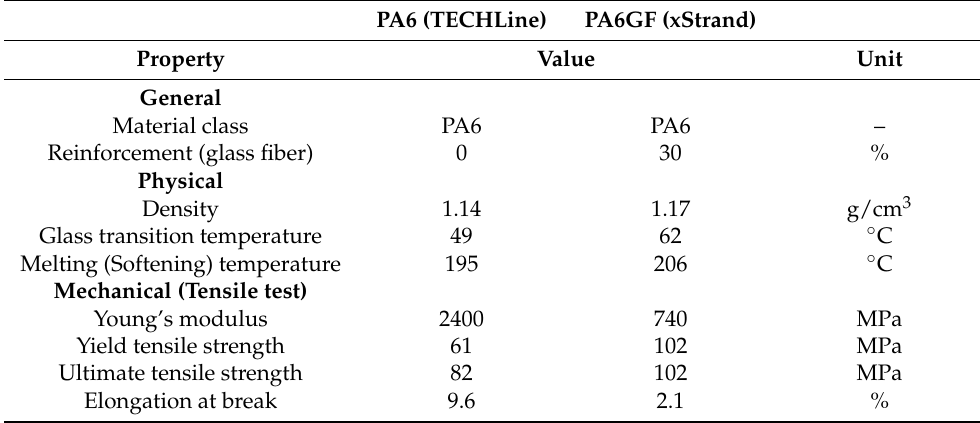
Table 1. Main properties of the investigated PA6 materials.